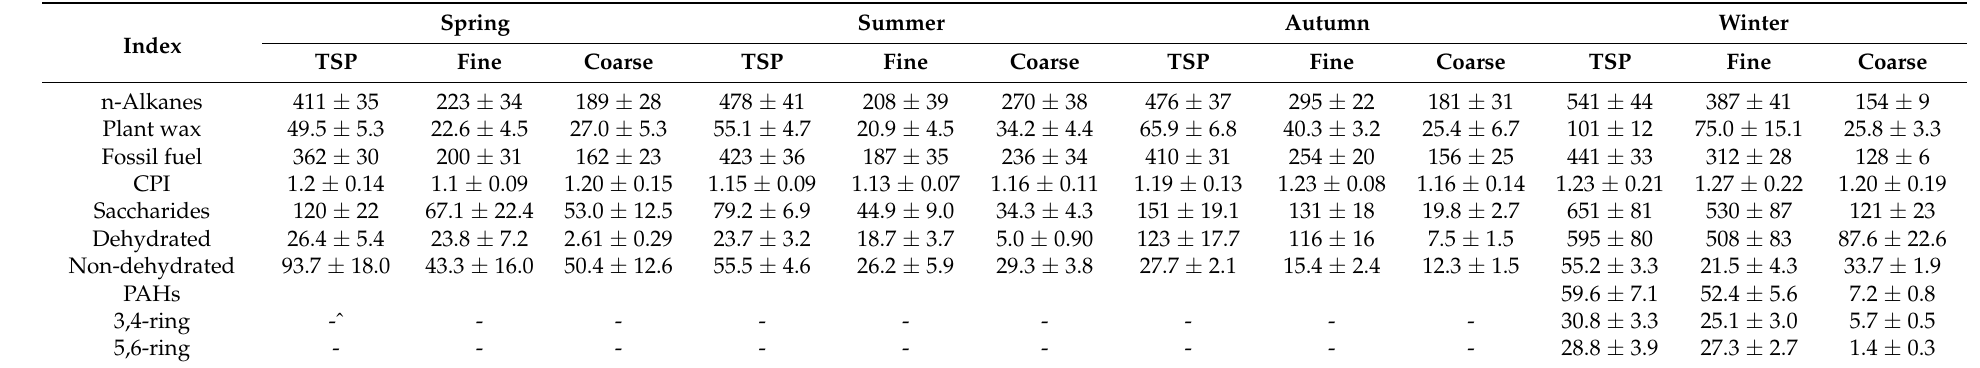
Table 1. Mass concentrations of n-alkanes, saccharides, and PAHs (ng · m − 3 ) of the fine (<2.1 µ m) and coarse ( ≥ 2.1 µ m) particles and the whole range of impactor particle sizes (total) in the four